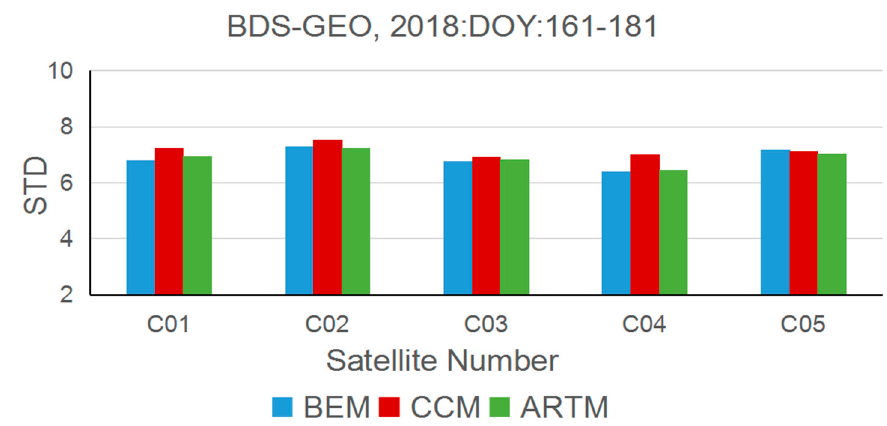
Figure 5. The STD of the satellite repeat shift time for the three methods for each satellite during the period DOY:161–181, 2018.